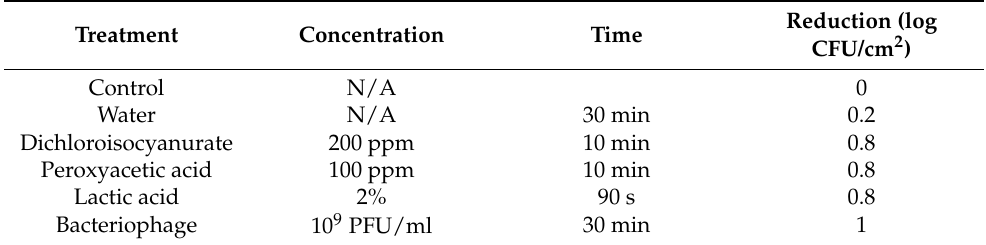
Table 5. Various treatment methods of S . enteritidis on chicken skin and the resulting reductions (adapted from [104]). Treatment